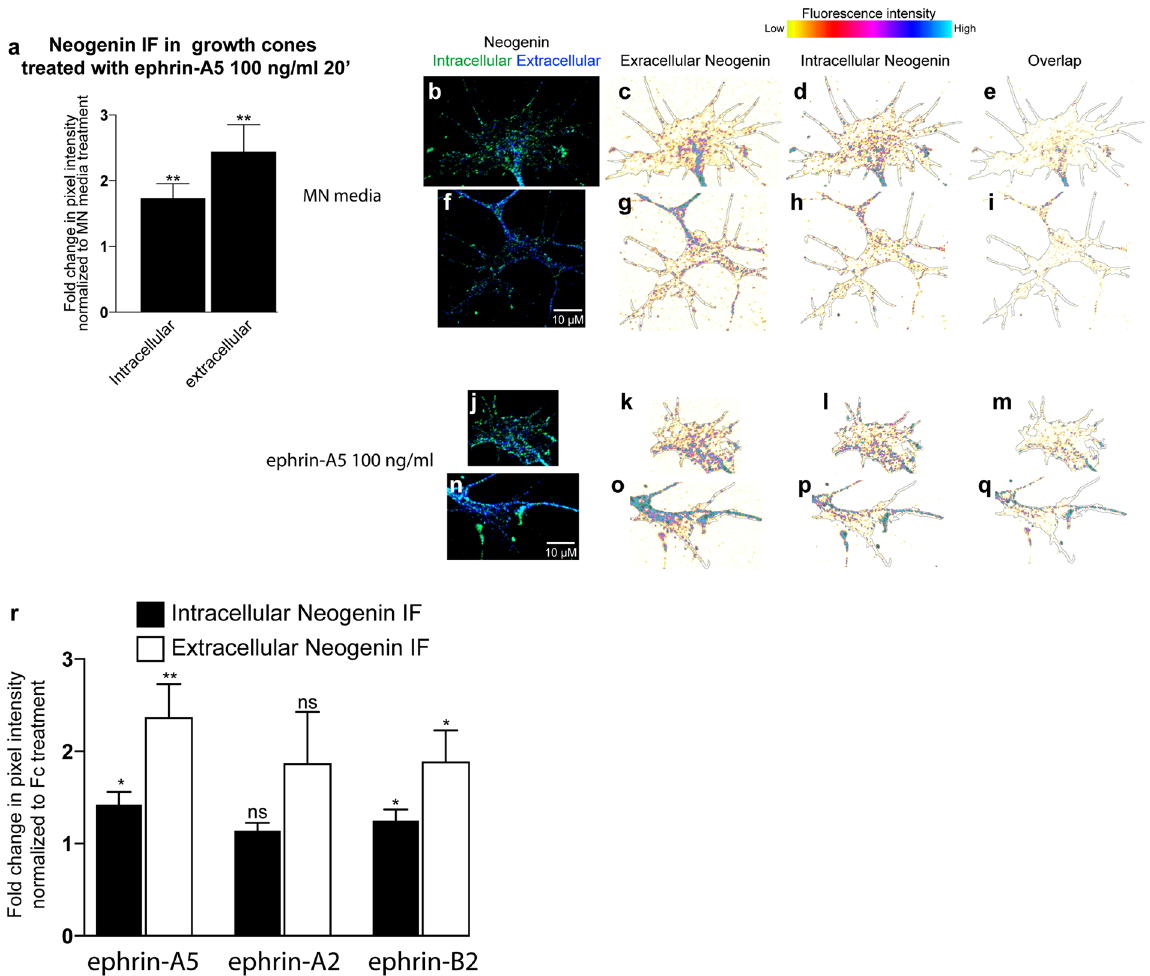
Figure 3. Ephrin-A5 and Ephrin-B2 increase both intracellular and extracellular Neogenin IF. ( a – q ) Compared to MN media, ephrin-A5 100 ng/mL increases both intracellular and extracellular Neogenin IF in LMC growth cones (1.7 ± 0.2-fold, p = 0,005; 2.4 ± 0.4-fold, p = 0,004 respectively, N = 7). ( b – q ) Examples of growth cones quantified in ( a ). ( r ) A 20 ′ exposure to ephrin-A5, ephrin-B2 but not ephrin-A2 at 100 ng/mL increases intra. and extra. Neogenin IF in LMC growth cones (ephrin-A5 intra. Neogenin IF: 1.4 ± 0.1-fold, p = 0,006; ephrin-A5 extra. Neogenin IF: 2.3 ± 0.4-fold, p = 0.002; ephrin-A2 intra. Neogenin IF: 1.1 ± 0.1-fold, p = 0.06; ephrin-A2 extra. Neogenin IF: 1.9 ± 0.6-fold, p = 0.08; ephrin-B2 intra. Neogenin IF: 1.2 ± 0. 1-fold, p = 0.034; ephrin-B2 extra. Neogenin IF: 1.9 ± 0.3-fold, p = 0.015. N = 6. Data are shown as mean ± SEM, statistical significance was tested using a two-tailed ( a ) and one-tailed ( r , s ) unpaired sample